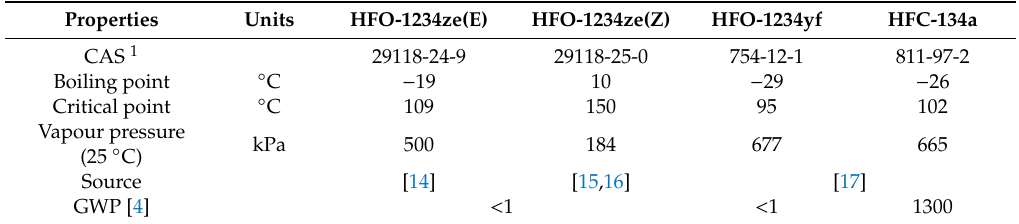
Table 1. Thermodynamic properties of hydrofluoroolefins (HFOs) compared to hydrofluorocarbon